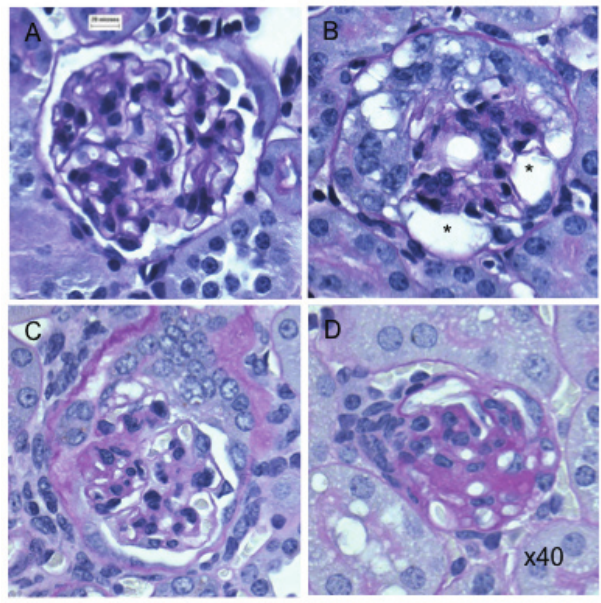
Figure 3. Glomerular histology of DT treated and untreated mice. ( A ) Normal glomerulus in untreated transgenic mouse. ( B ) Damaged glomerulus with abnormal morphology and vacu- olated cytoplasm (*) from treated Podo-DTR line 47 (25ng/g bw DT) at D7. ( C – D ) Sclerosed glomeruli from treated Podo-DTR line 57 (1ng/g bw DT) at D28 with ( C ) partially damaged glomerulus with normal morphology at 4 o’clock, with tuft/capsular adhesion in the area of segmental scar at 9 o’clock, and ( D ) almost completely sclerosed glomerulus. PAS staining, 40x magnification. * p=0.002; ** p<0.0001; DT, diphtheria toxin; bw, body weight; D, day; NS, non significant; PAS, Periodic Acid Schiff.